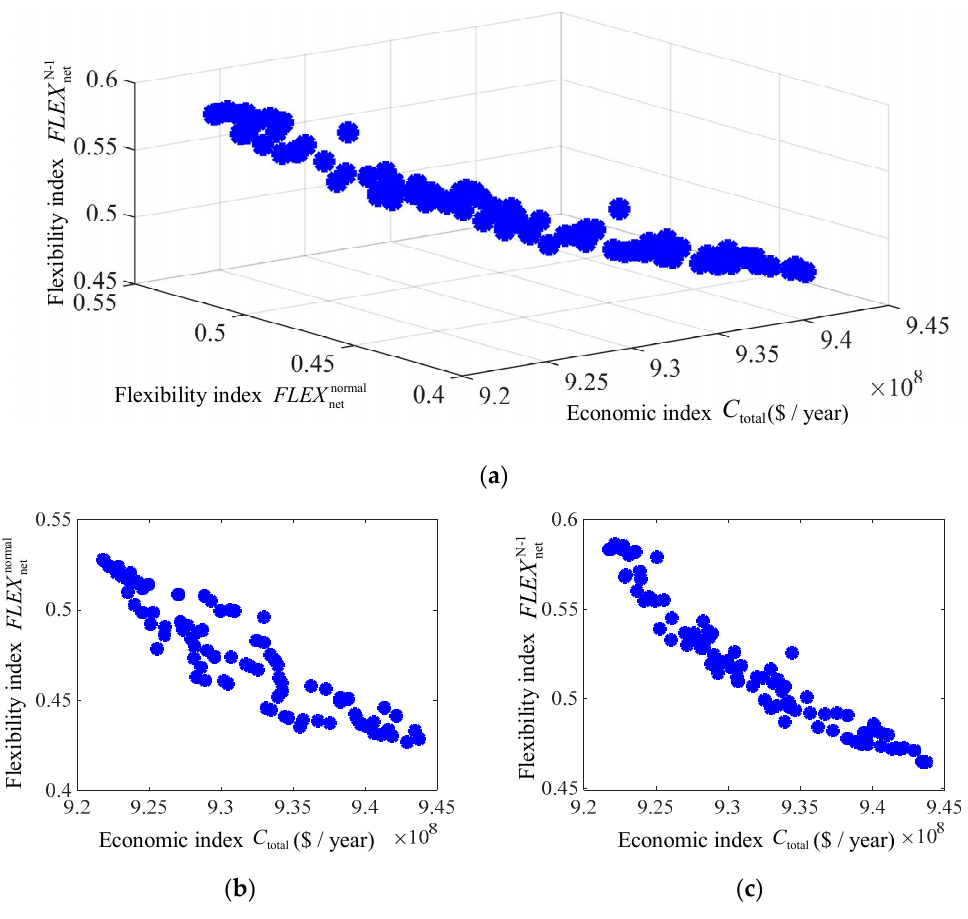
Figure 7. Flexibility–Economy Pareto Frontier. ( a ) The total planning cost—Normal power grid flexibility index—N-1 power grid flexibility index Pareto Frontier; ( b ) FLEX normal N-1 FLEX projection. net